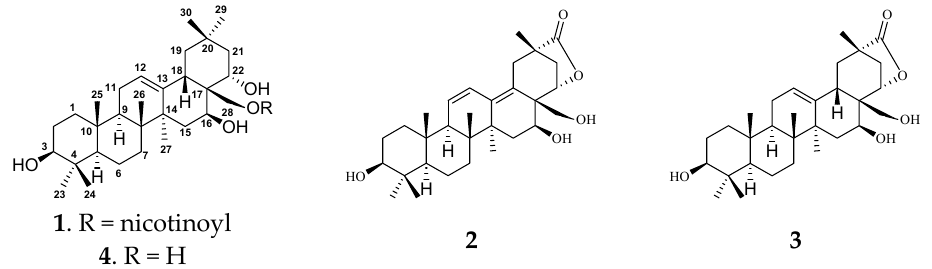
Figure 1. Chemical structures of compounds 1 – 4.